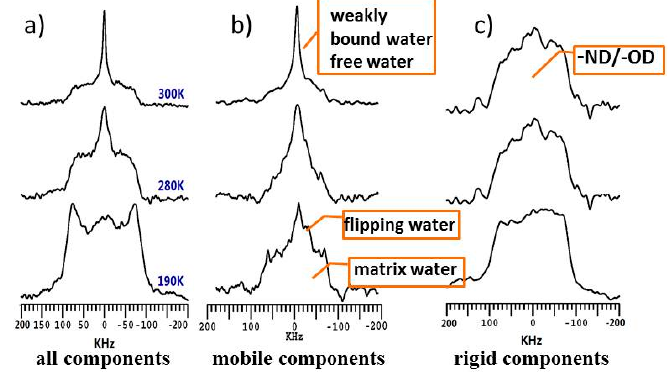
Figure 3. Dynamic-editing VT 2 H NMR spectra for CTS-N obtained from: ( a ) quadrupolar echo; ( b ) saturation recovery quadrupolar echo; and ( c ) Torchia’s T 1 filter quadrupolar echo experiments, respectively.